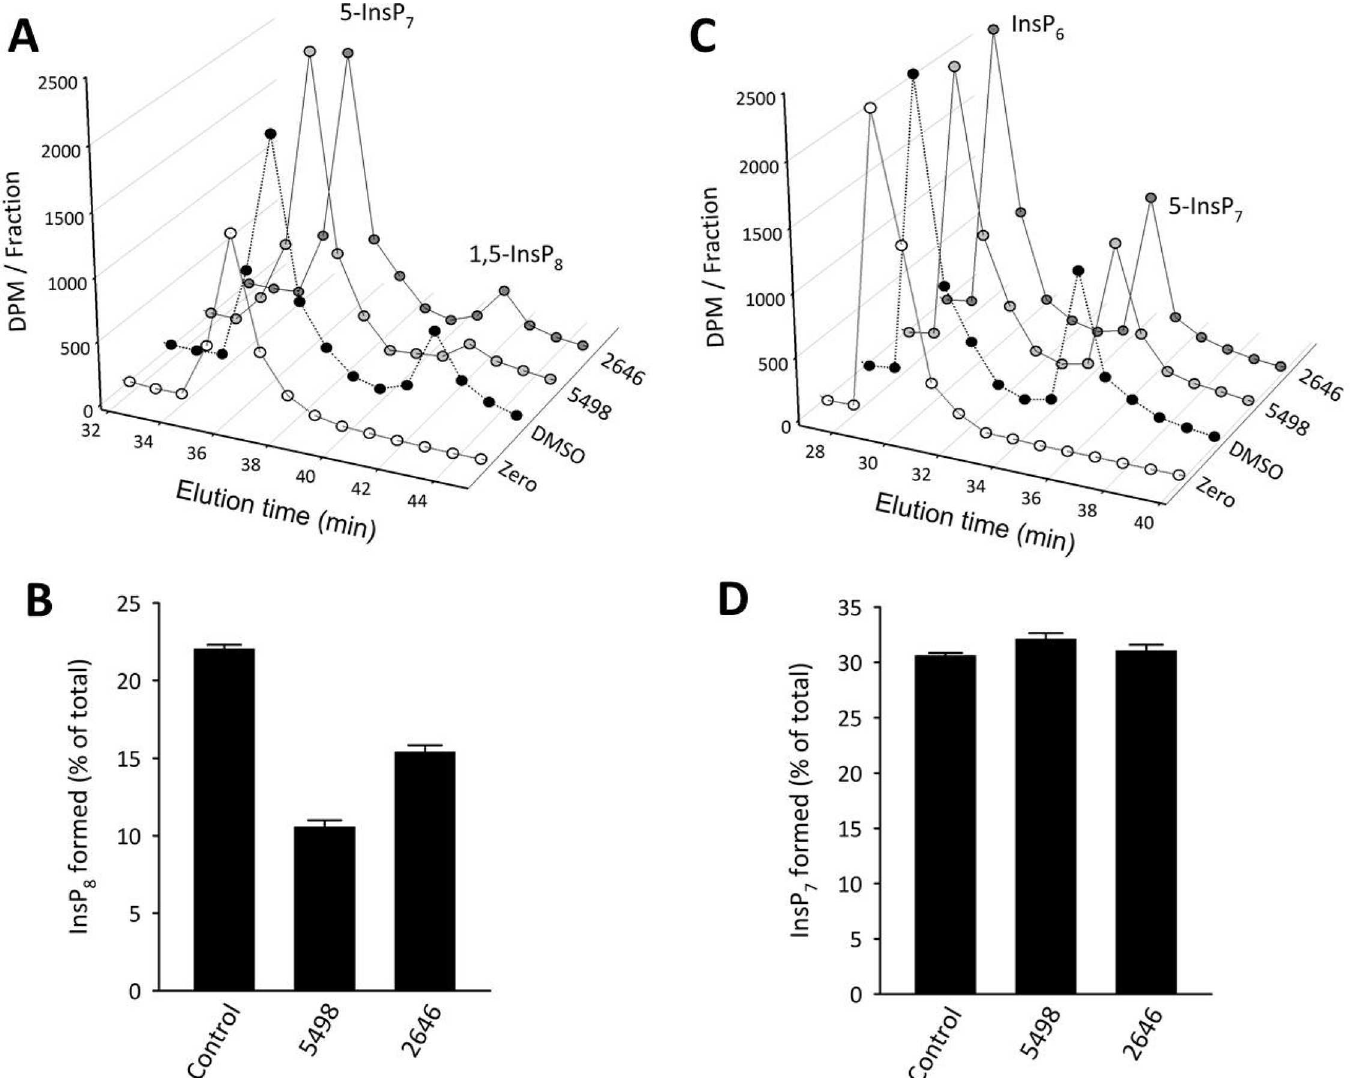
Fig 8. HPLC analysis of the effects of UNC10225498 and UNC10112646 upon the kinase activities of PPIP5K and IP6K. Kinase reactions contained either vehicle (0.5% DMSO) or inhibitor in 0.5% DMSO. Reactions were quenchedand analyzedby HPLC as describedin the methods section. Representative HPLC data are shown for both (A) PPIP5K and (C) IP6K, includingno enzyme control (open circles), vehicle control (closed circles), 10 μ M UNC10225498 (‘5498’,light gray circles), or UNC10112646(‘2646’, dark gray circles). Panels B and D show the means and SEM for the percentage of product formed in 3